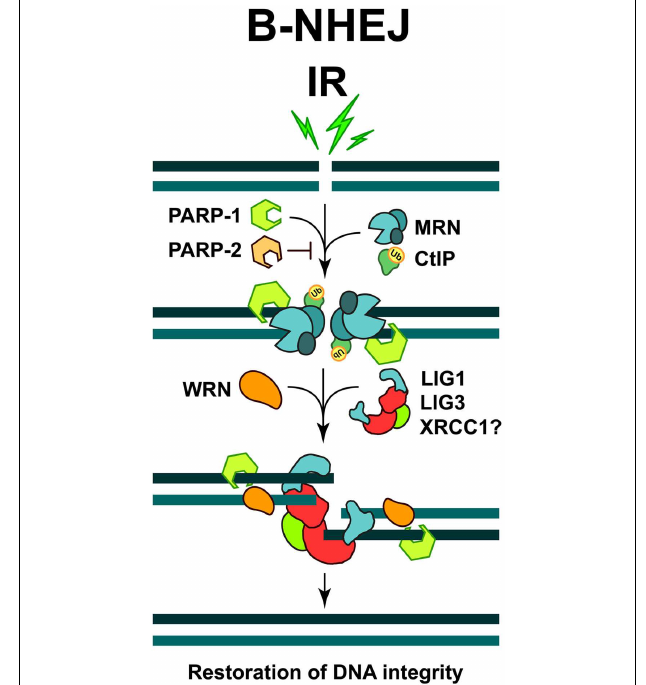
FIGURE 2 | Repair of DSBs by B-NHEJ .This pathway remains incompletely characterized. Factors implicated include PARP-1, the MRN complex, CtIP, andWRN. Ligation is mediated by LIG3 or LIG1.The restoration of DNA integrity through this repair pathway is also associated with sequence information loss at the junction, and more importantly, by increased risk of joining unrelated DNA ends to generate translocations and other genomic